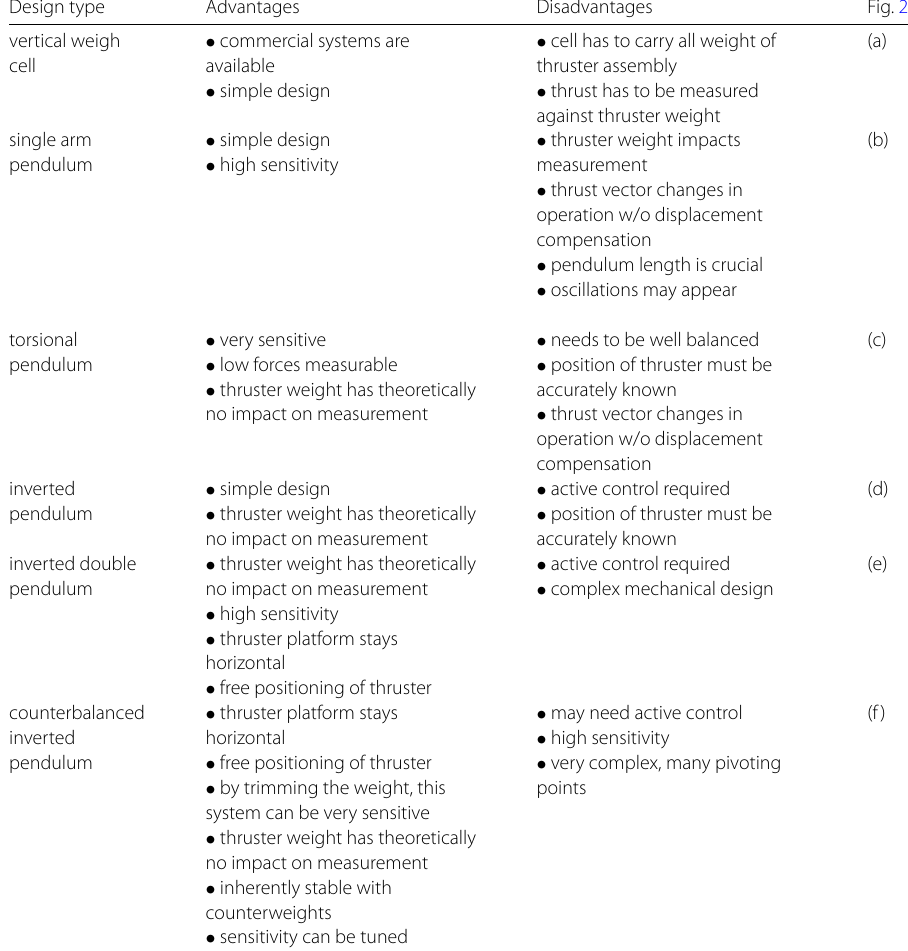
Table 1 Characteristics of basic design concept of thrust balances as shown in Fig.